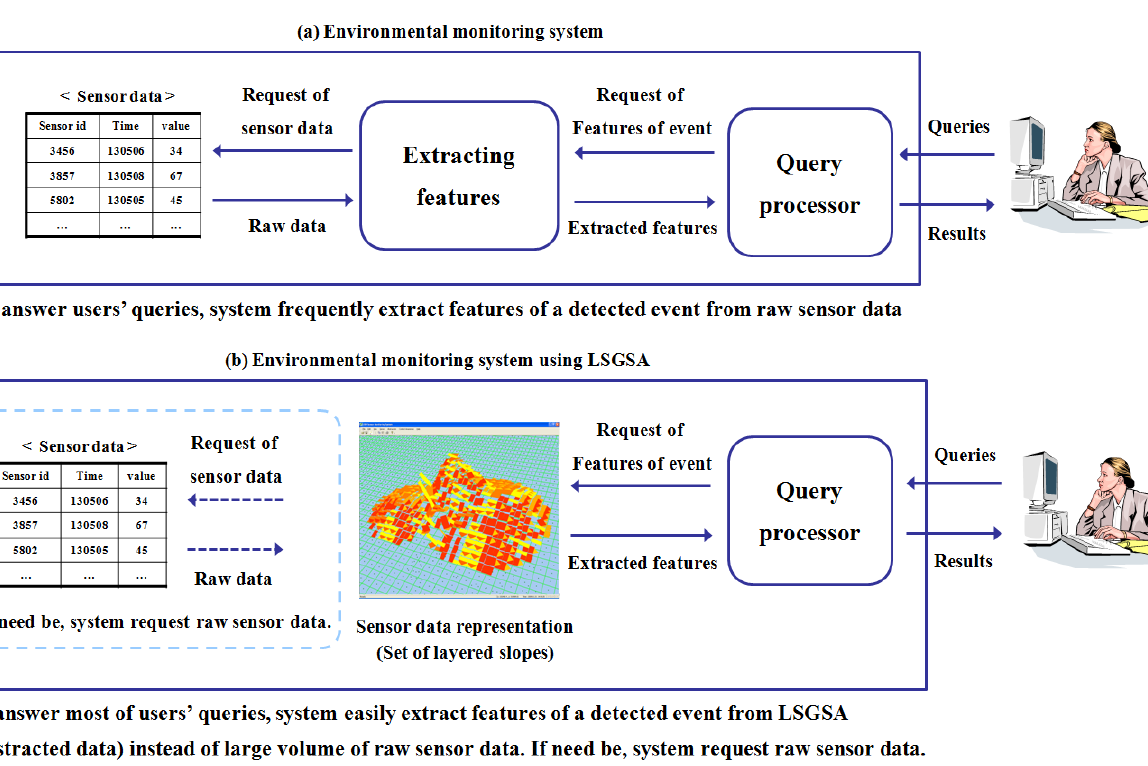
Figure 3. Query processing with